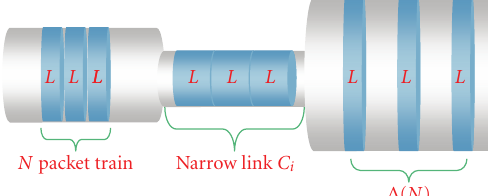
Figure 1: Illustration of bandwidth estimation using packet train